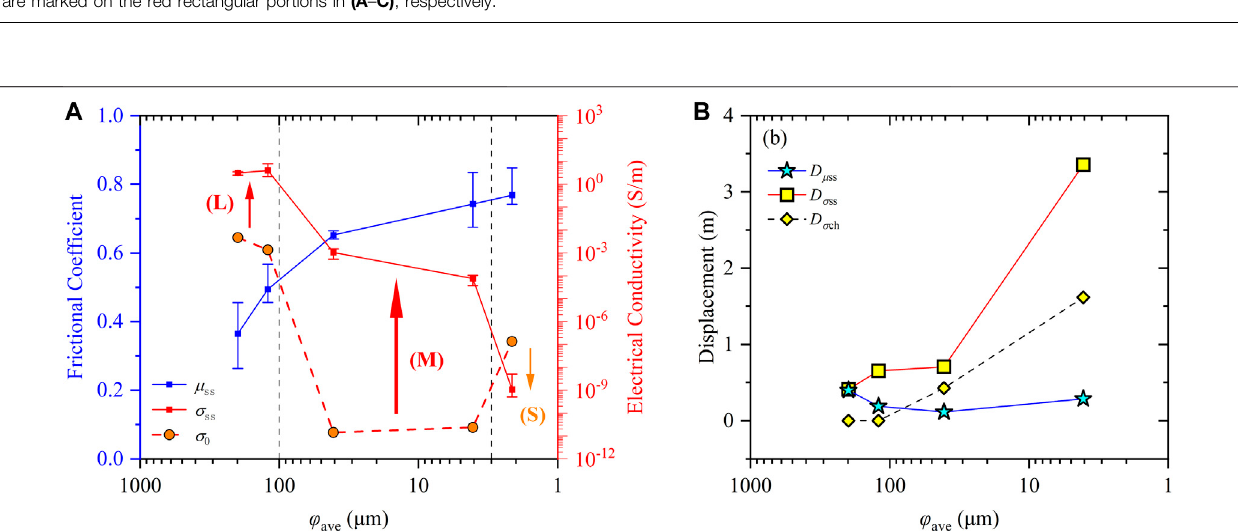
FIGURE 6 | (A) Effect of φ ave on μ ss (blue squares on the blue solid line), σ 0 (orange circles on the red dashed line), and σ ss (red squares on the red solid line) of the 6 wt%Gr-bearinggouges. Theerror bars indicate therange ofvariationin theexperimental dataduring the steady-state. Theentire range of φ ave for initialQzparticlesin this study is divided into three regimes bounded by 100 and 3 μ m (black dotted lines), i.e. , large (L), medium (M), and small (S) particle size regimes. The direction of the arrowsindicatesthetrendof σ ss comparedto σ 0 duringaprogressivefaultslip. (B) Effectof φ ave onthecriticalslipdisplacementoftheGr-bearinggouges,including D μ ss (blue stars on the blue solid line), D σ ch (yellow diamonds on the black dashed line), and D σ ss (yellow squares on the red solid line).